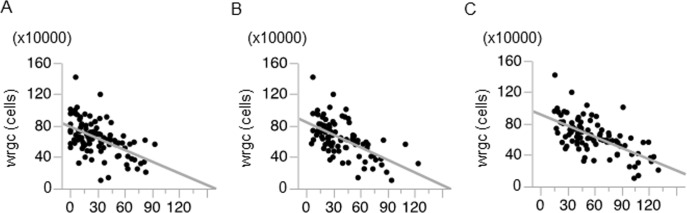
Association between RNFLD angle and wrgc.Scatter plot showing the correlation coefficient between RNLDA and wrgc in the en-face image 1 (A), en-face image 2 (B), and en-face image 3 (C).